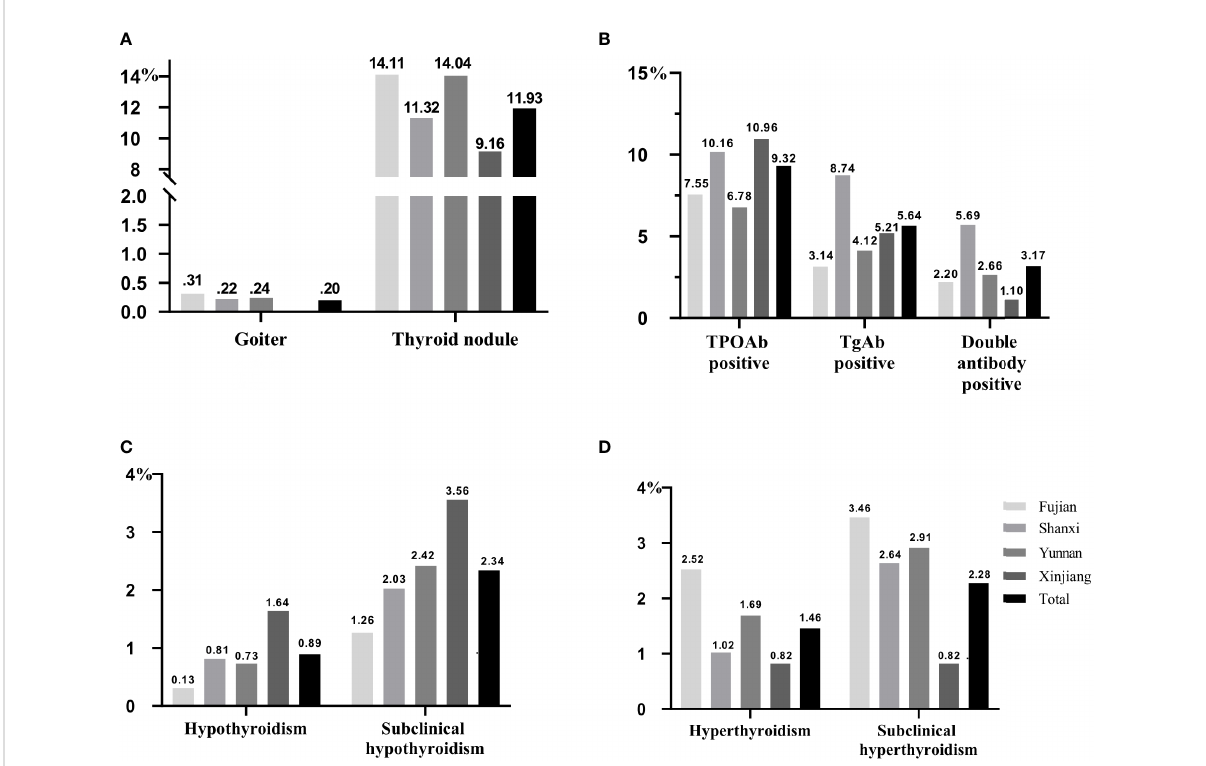
FIGURE 4 The prevalence of thyroid diseases in pregnant women. All data were presented as prevalence rate. (A) The prevalence of thyroid goiter and nodule. (B) The prevalence of antibody positive. (C) The prevalence of hypothyroidism and subclinical hypothyroidism. (D) The prevalence of hyperthyroidism and subclinical